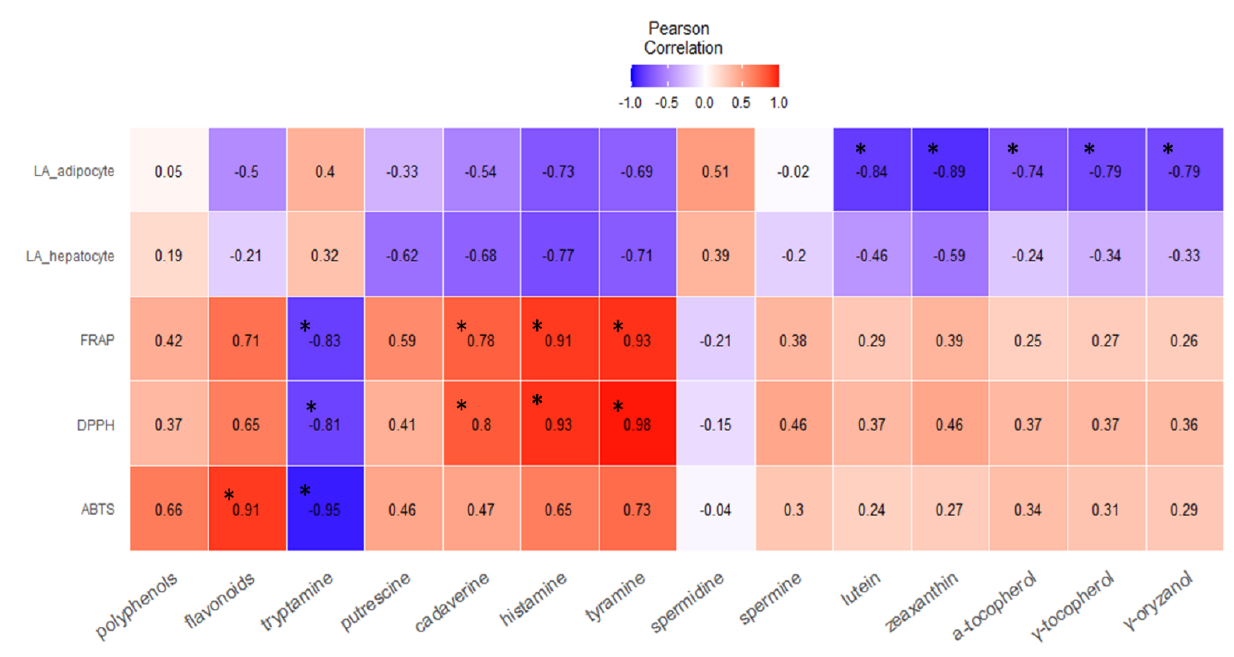
Figure 7. Heatmap showing Pearson’s correlation. Correlations between bioactive compounds and the antioxidant and antilipidemic activities of wheat germ extracts are shown. ABTS, DPPH, and FRAP show antioxidant activity, whereas the LA_hepatocyte and LA_adipocyte factors indicate an antilipidemic effect in those two cell types. The asterisk (*) shows significant differences ( p < 0.05). LA_adipocyte, lipid accumulation in adipocytes; LA_hepatocyte, lipid accumulation in hepatocytes; FRAP, ferric reducing antioxidant power; DPPH, 2,2-diphenyl-1-picrylhydrazyl; ABTS, 2,2-azino-bis(3- ethylbenzothiazodine-6-sulfonic acid).